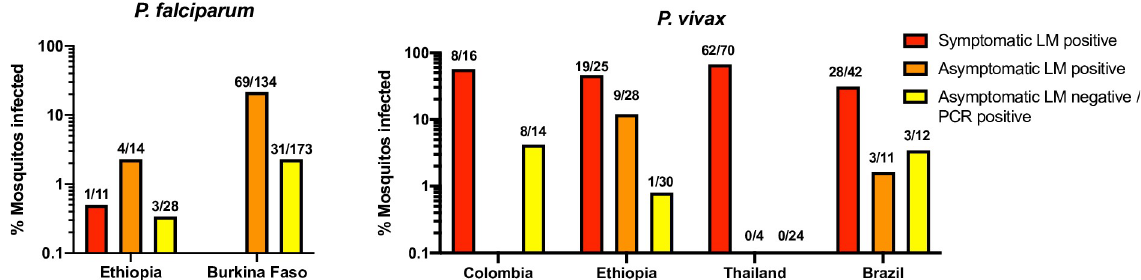
Fig 5. Infectivity of P . falciparum and P . vivax infections in membrane-feeding assays based on clinical status and ability of light microscopy to diagnose infections. ‘% Mosquitos infected’ shows the combined proportion of mosquitos infected including individuals that did not infect any mosquitos. n/N show the proportion of individuals that infected at least one mosquito. Infectivity varied widely, but with the exception of the study on P . vivax in Brazil, microscopy-positive individuals were 5-10-fold more infective that those with submicroscopic infection. Data from [45,